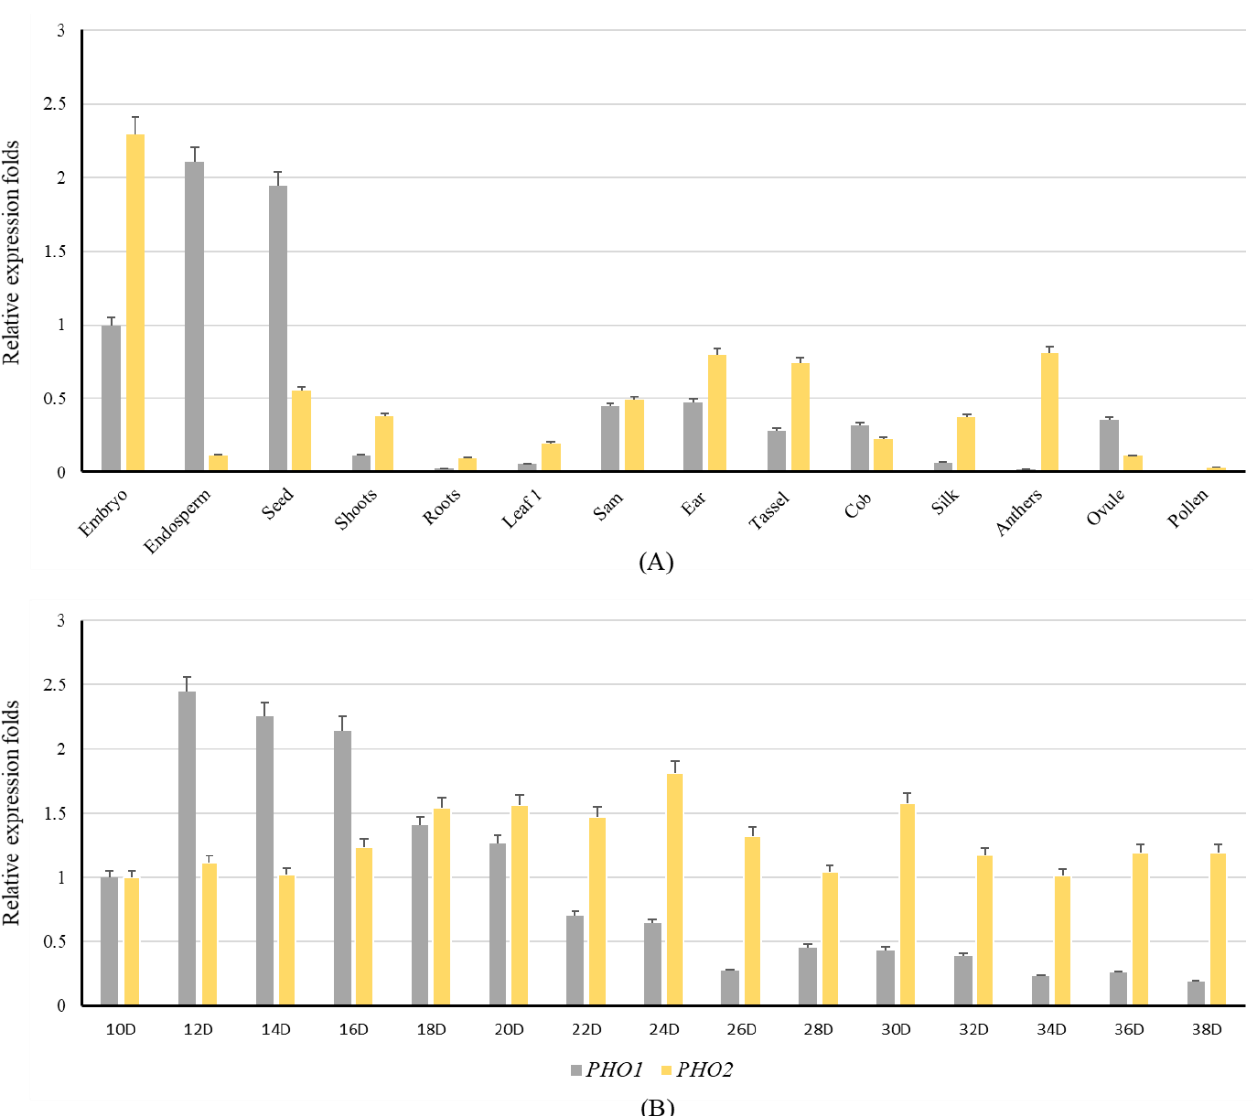
Figure 7. Distribution and expression pattern of the PHO1 and PHO2 transcripts of Z. mays: ( A ) Tissue-specific expression levels of the PHO1 and PHO2 of Z. mays . The relative expression pattern is shown and the transcript level in the embryo is used as control. The leaf1 is the first leaf harvested from the mature plant when it is flowering. The 15 DAP seeds and dissected endosperm were used to analyze the transcript level; ( B ) Relative expression levels of the PHO1 and PHO2 of Z. mays in different developmental stages of the endosperm. The transcript level in 10 DAP endosperm was used as a control.